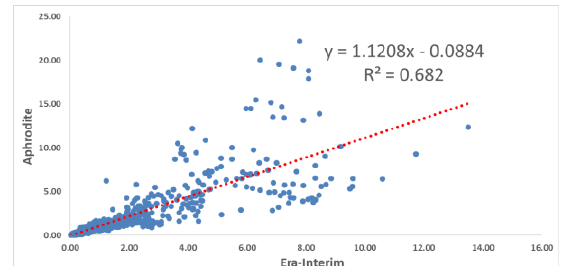
Figure 17. Scatter plot between daily rainfall in JJAS season of Era-Interim and APHRODITE rainfall products